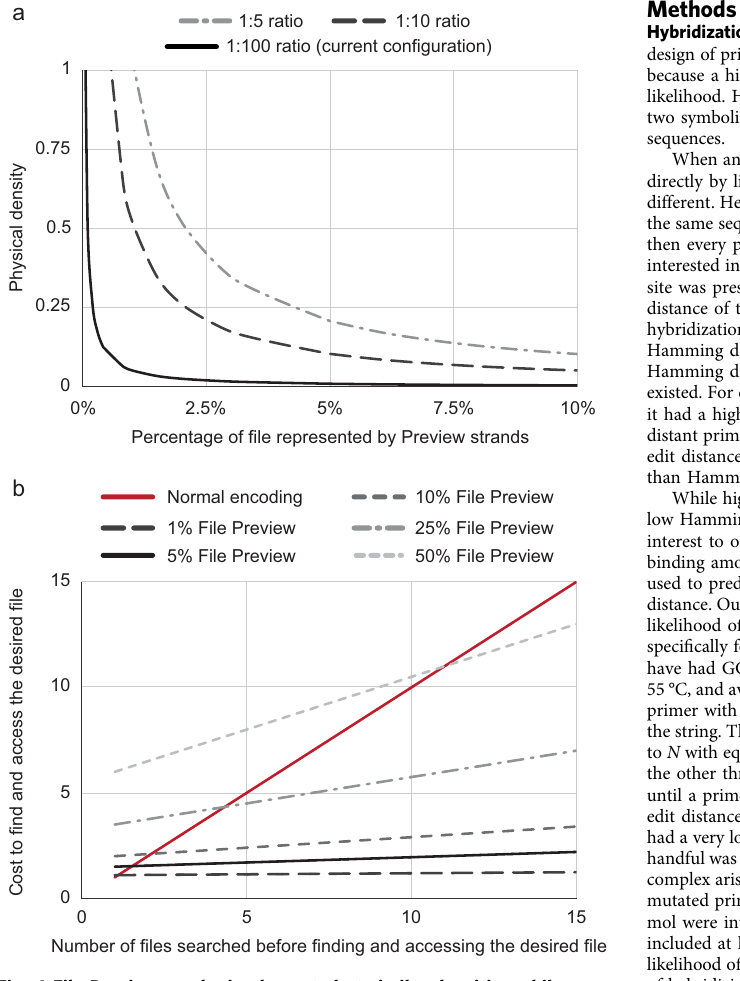
experimental screening.